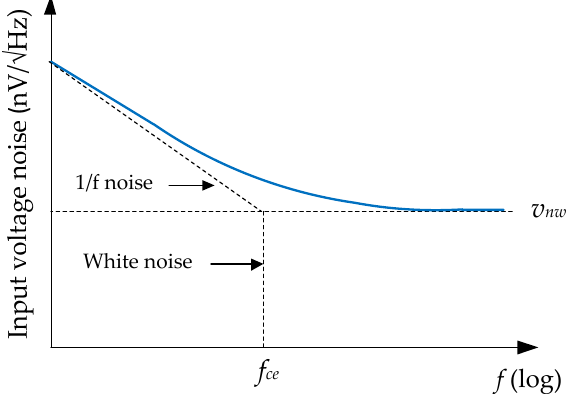
Figure 8. Input voltage noise spectral density vs. frequency [35].